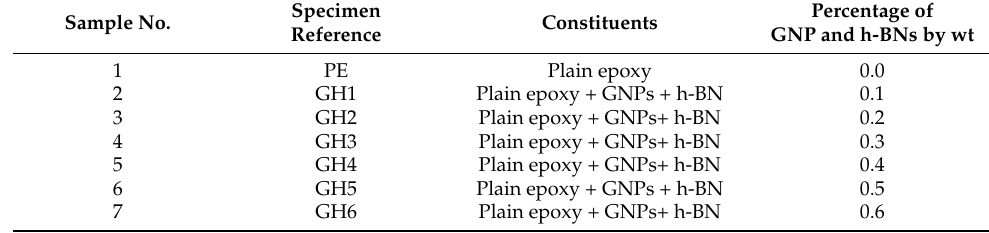
Table 3. Test specimen details (GNP and h-BN).